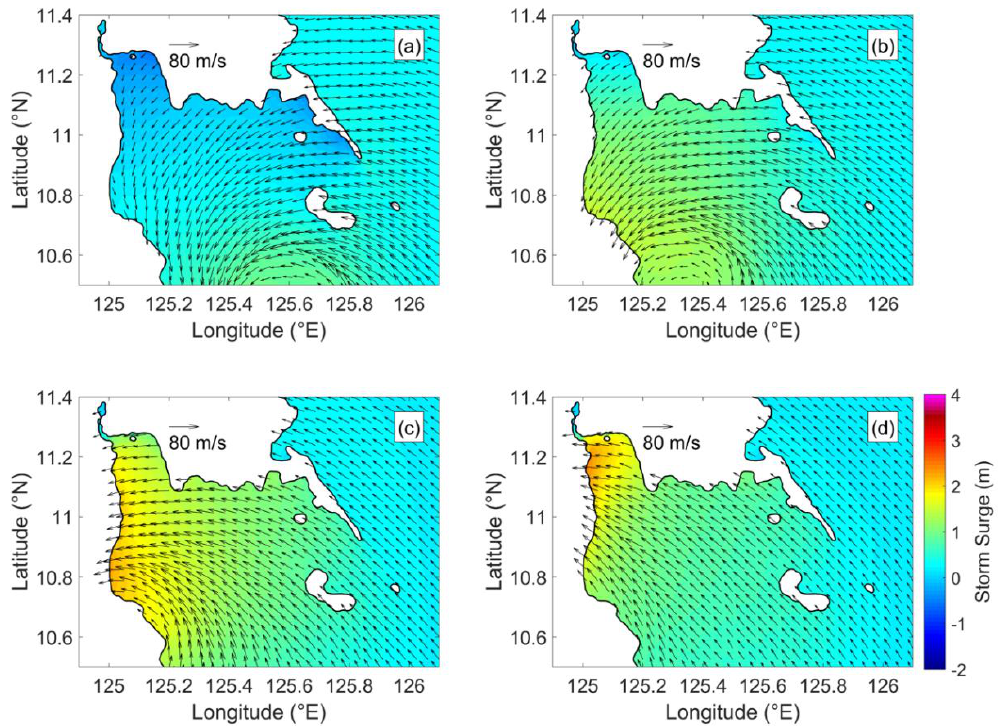
Figure 13. Snapshots of the computed storm surges driven by WRF-ARW 1 km at the times of: ( a ) 02:00 UTC 8 November 2013; ( b ) 03:00 UTC 8 November 2013; ( c ) 04:00 UTC 8 November 2013; ( d ) 05:00 UTC 8 November 2013. The color shading indicates the storm surge in m, and the black line depicts the coastline of the storm surge model. The arrows depict the 10-m winds of WRF-ARW 1 km per every 15 grids over the domain. These snapshots have been zoomed in from the original computational domain.